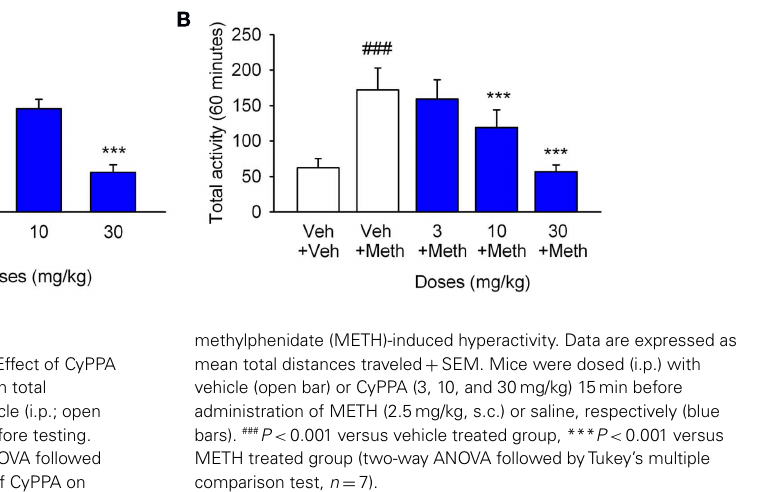
methylphenidate (METH)-induced hyperactivity. Data are expressed as mean total distances traveled + SEM. Mice were dosed (i.p.) with vehicle (open bar) or CyPPA (3, 10, and 30mg/kg) 15min before administration of METH (2.5mg/kg, s.c.) or saline, respectively (blue bars). ### P < 0.001 versus vehicle treated group, *** P < 0.001 versus METH treated group (two-way ANOVA followed byTukey’s multiple comparison test, n = 7).